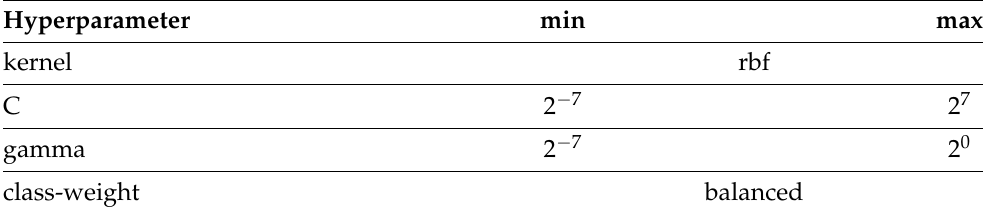
Table 2. Evaluated hyperparameters for the SVC with RBF